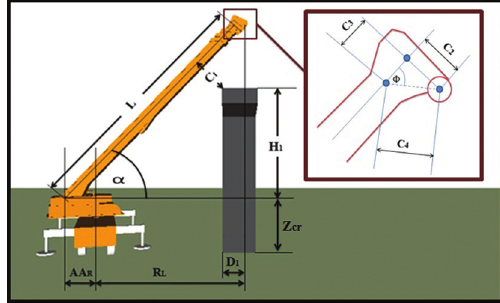
Fig. 5. Parameters of GA